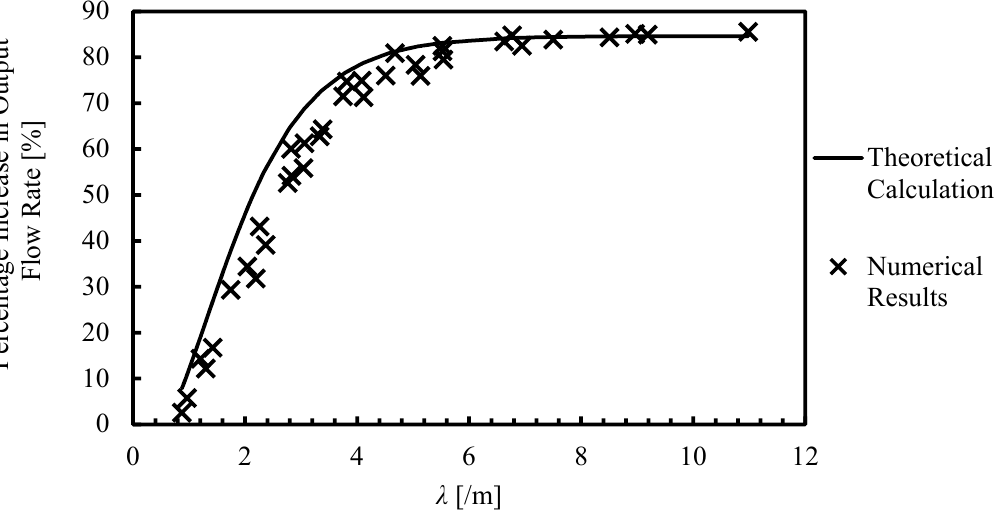
Figure 14. Correlation between λ and the percentage increase in permeate output flow rate.